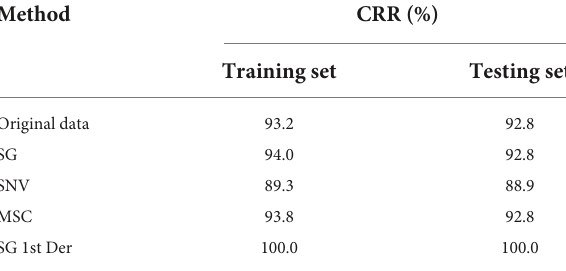
TABLE 6 Summary of FDA modeling results for bacteria species identification expressed in